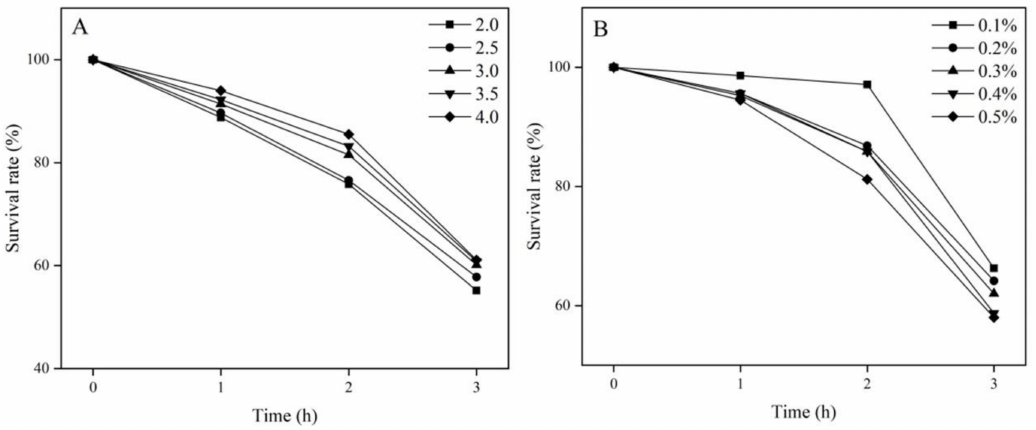
Figure 4. Tolerance of Lactococcus garvieae FUA009 in vitro at different pHs ( A ) and concentrations of bile salts ( B